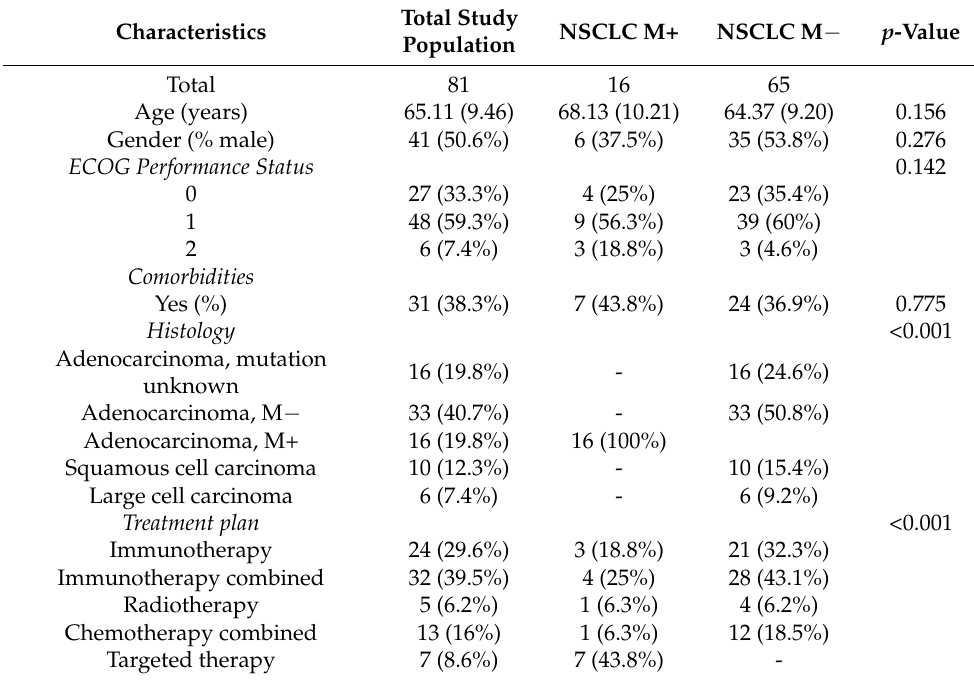
Table 1. Baseline